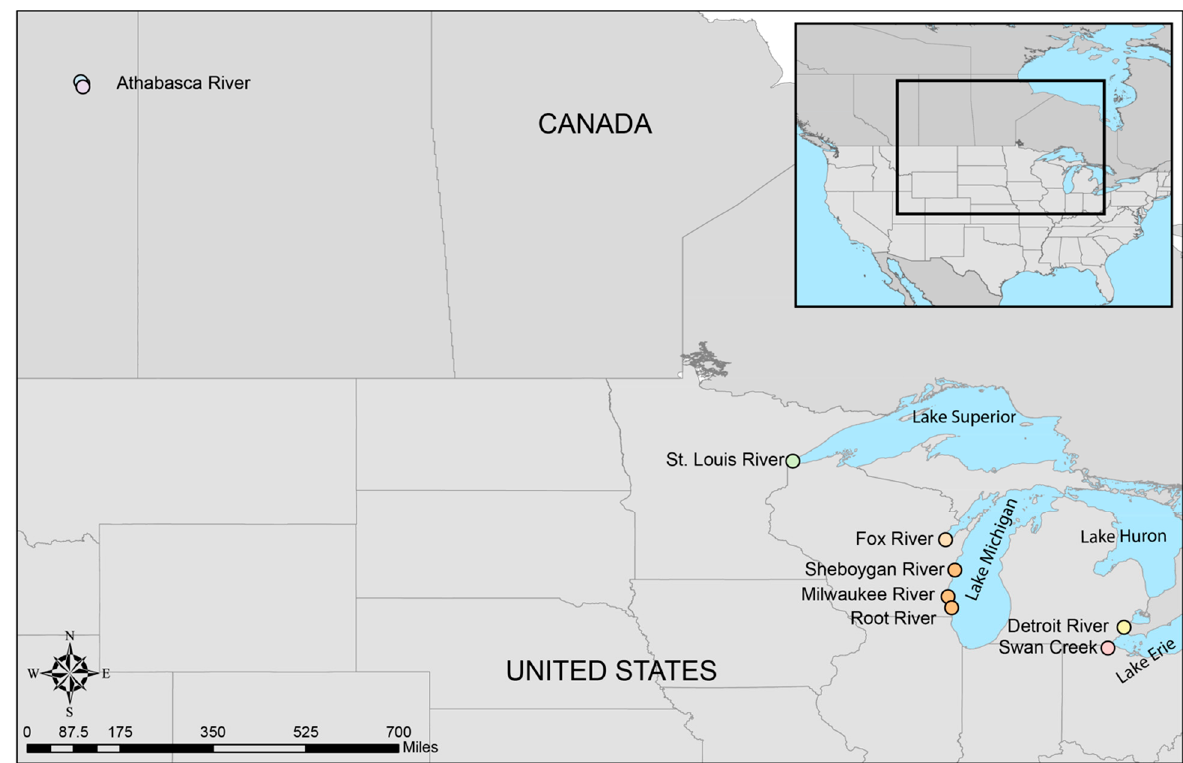
Figure 1. Sampling locations of white sucker within the Great Lakes and Lake Athabasca Basins. Color coding of sampling sites is retained in subsequent figures.